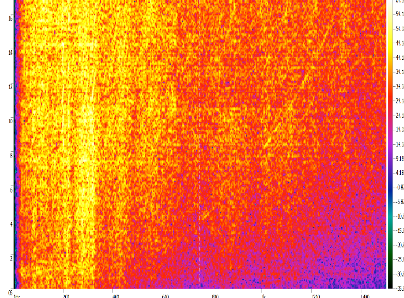
Fig. 6. The Acoustic sensors near driver's ear.